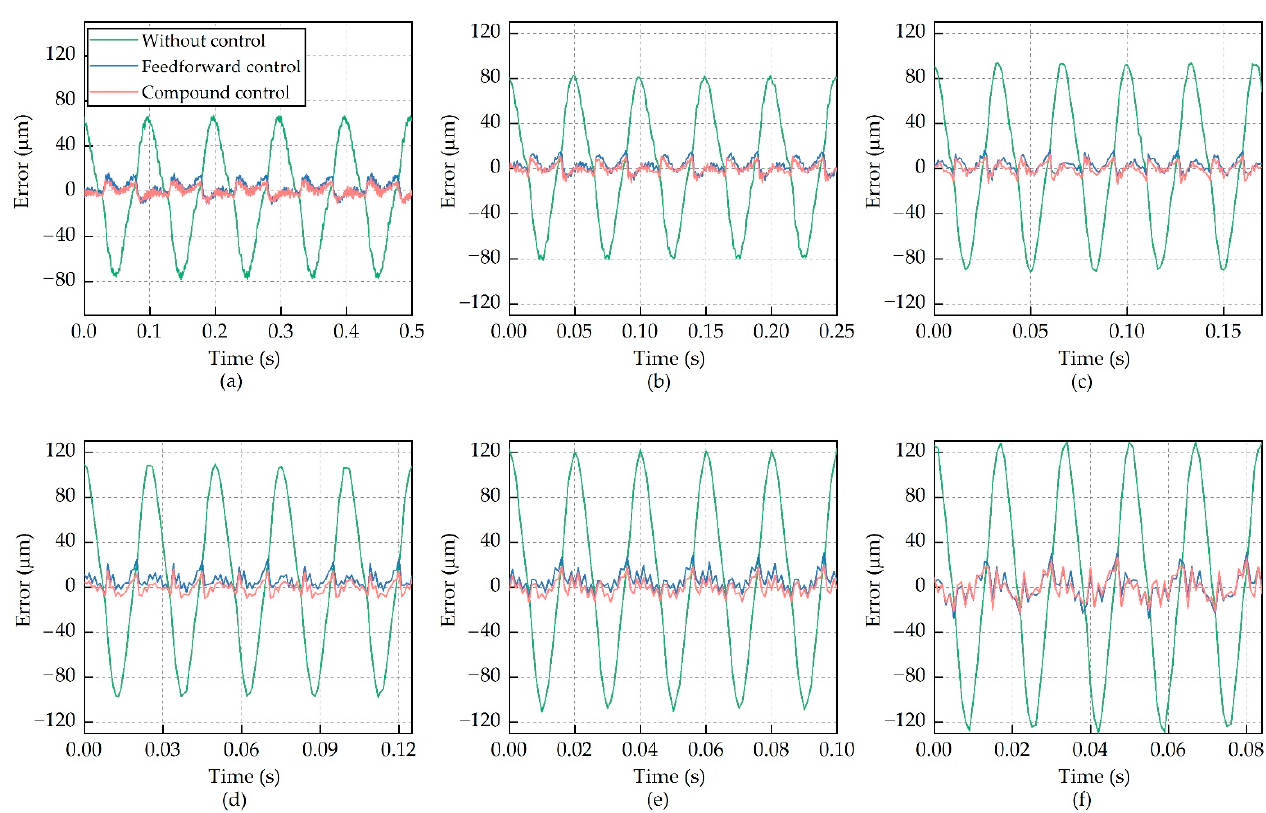
Figure 12. Errors between the desired outputs and the measured outputs. ( a ) 10 Hz; ( b ) 20 Hz; ( c ) 30 Hz; ( d ) 40 Hz; ( e ) 50 Hz; and ( f ) 60 Hz.